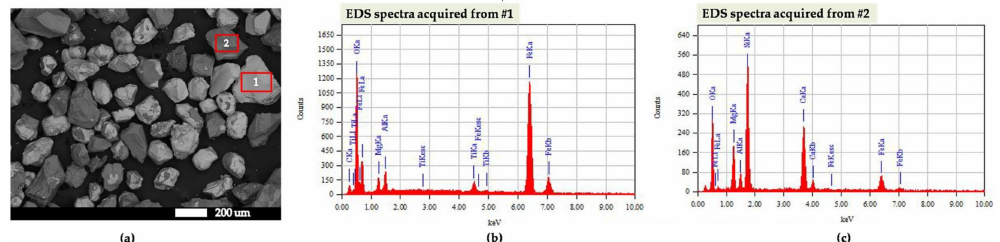
Figure 3. ( a ) Scanning electron microscopy images of the extracted sample obtained with the back-electron detector-shadow image mode; ( b ) energy dispersive spectroscopy spectra acquired from selected area #1; ( c ) energy dispersive spectroscopy spectra acquired from selected area